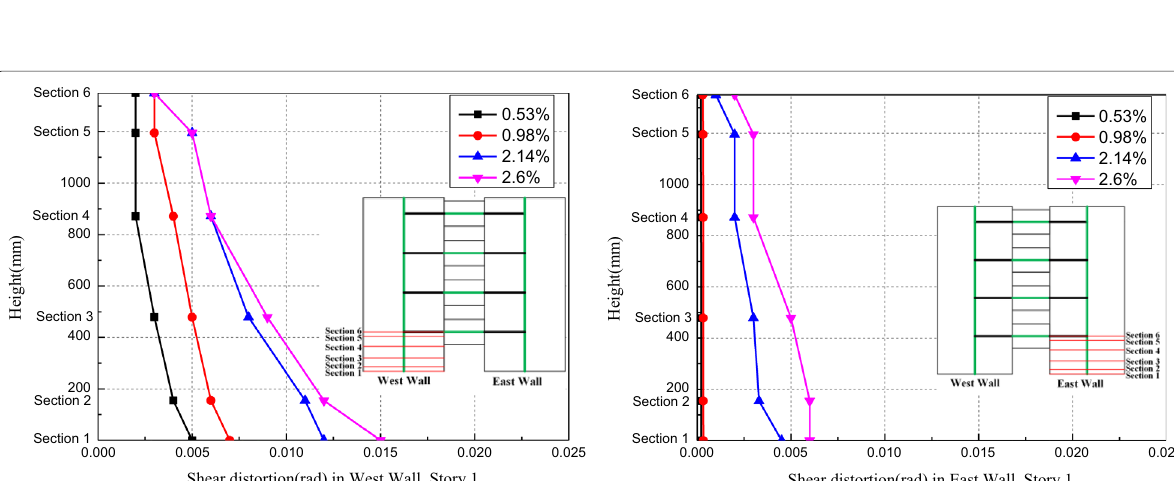
Fig. 19 Curvature of monitored sections (Gauss–Lobatto integration points) in positive drift direction of Specimen CW-1 (left right tension wall). =